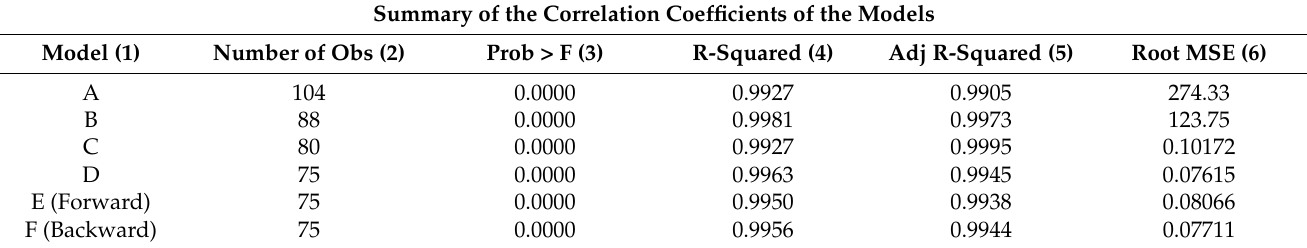
Table 9. General summary of the regression correlations obtained in each of the models formulated and analyzed. Summary of the Correlation Coefficients of the